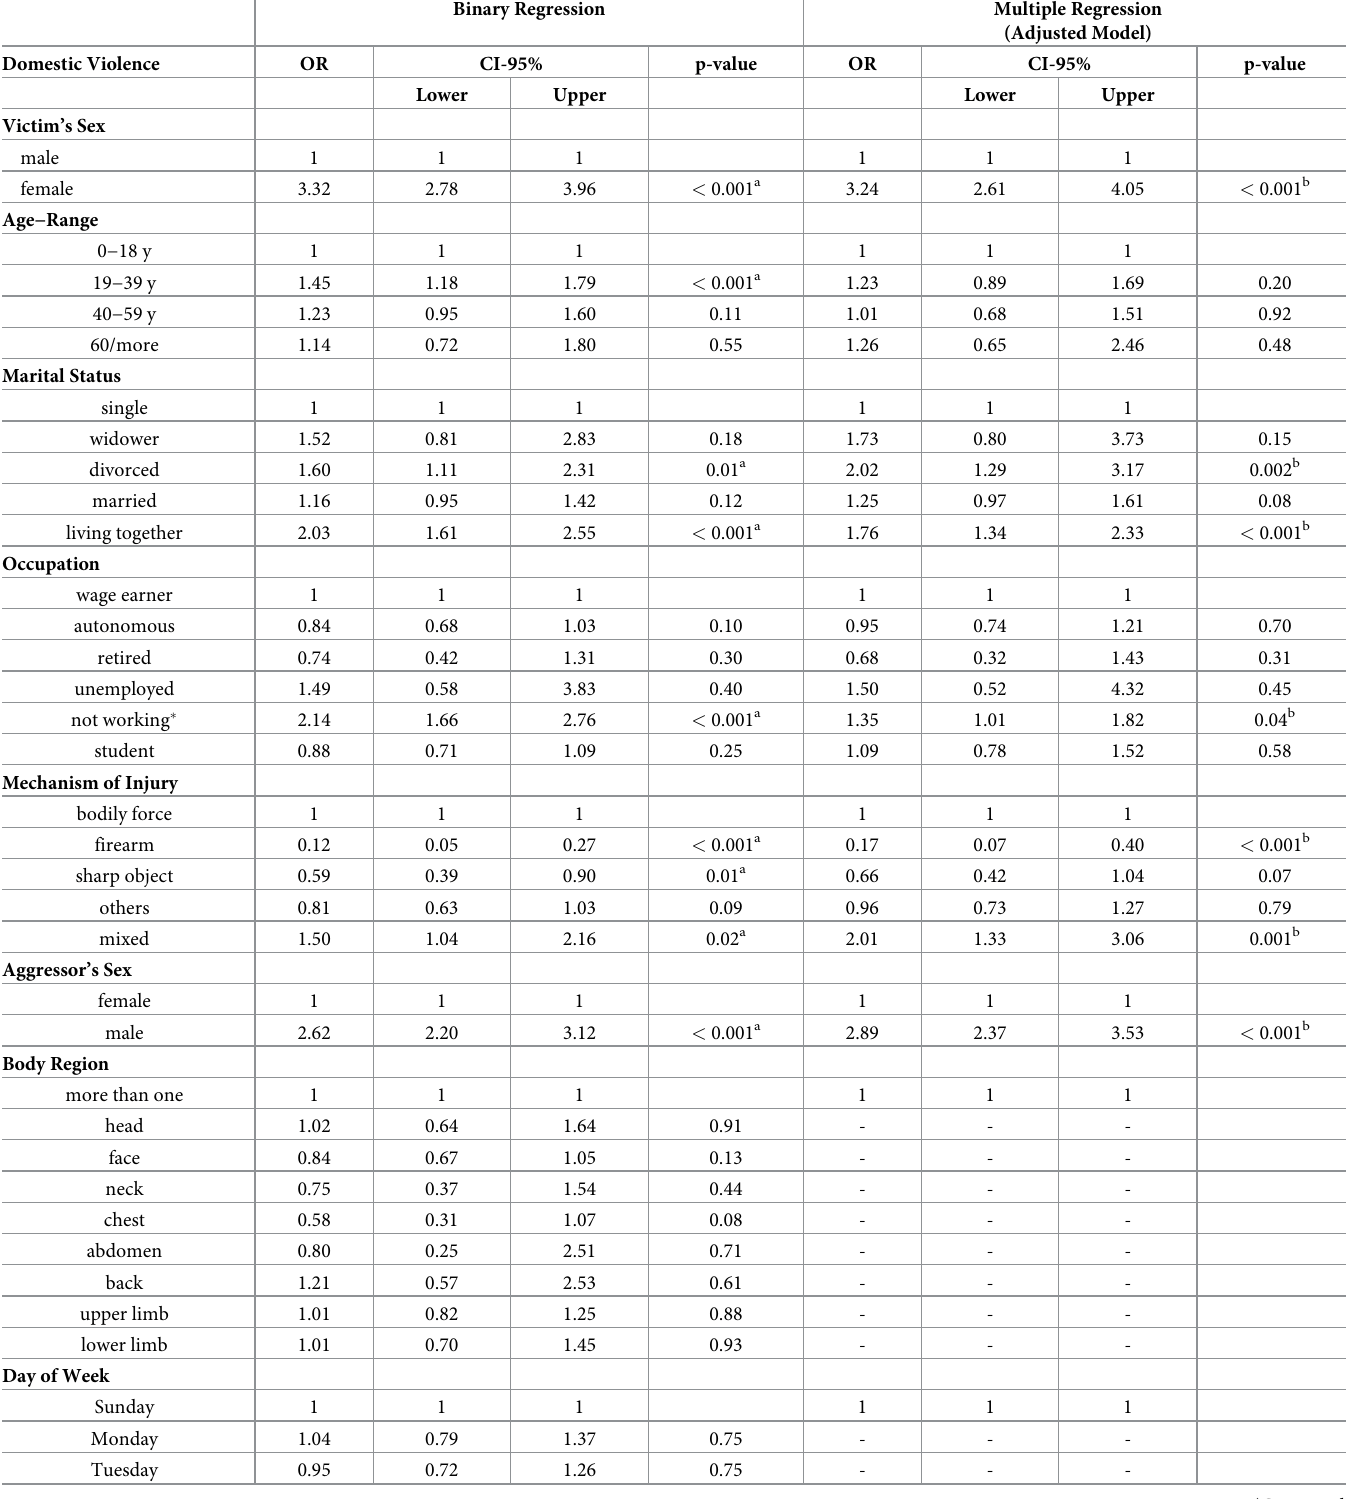
Table 2. Results of the binary and multiple regression with the adjusted